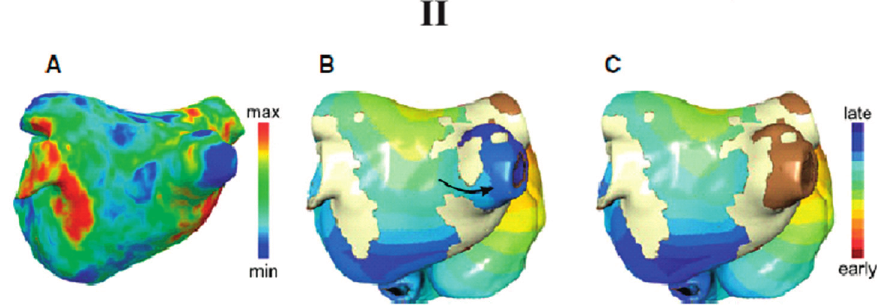
Figure 4. ( I ) The compound impact of structural remodeling on electrical propagations after a pulmonary vein (PV) focal beat. Reentry was observed only with both gap junction remodeling and fibroblast proliferation in fibrotic regions [53]. Reprinted from [53] with permission from Elsevier; Here the black arrows indicate the electrical propagation pathway; ( II ) A computer model of the left atrium (LA) was employed to evaluate effects of ablation lesion gaps [58]. ( A ) 3D late gadolinium-enhanced MRI (LGE-MRI) indicates the possible scars (in red) as acute results of clinical ablation; ( B ) A computer model was used to demonstrate that the incomplete ablation lines led to electrical passing through; ( C ) An additional ablation lesion was created in the computer model and tested to isolate the PV and restore the sinus rhythm effectively. The black arrow indicates the potential electrical pathway. Reprinted from [58] with permission from